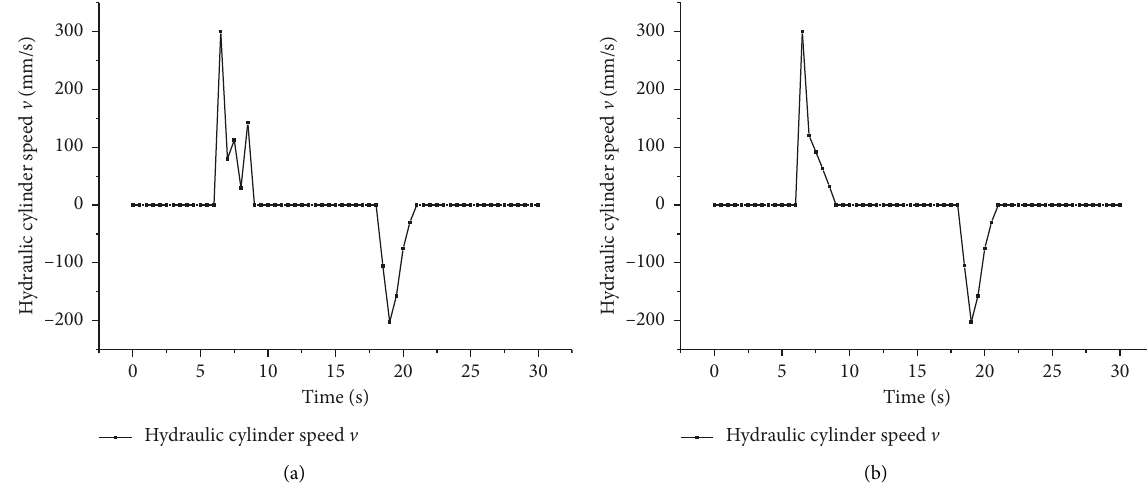
Figure 9: Hydraulic cylinder velocity and displacement curves. (a) Direct switching control. (b) Fuzzy switching control.